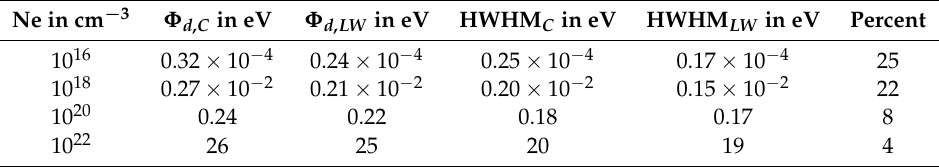
Table 1. Comparison between collision operators for Coulomb interaction Φ d , C and for Lienard Wiechert interaction Φ d , LW (multiplied by ¯ h in eV*s and by a 2 in cm 2 where a 0 is Bohr radius) at a 0 temperature T = 8 × 10 8 K and different densities and for Helium-like Ytterbium Z em = 68, for the radiative transition 1s3d to 1s2p for triplet case. After this muliplication, the following results are in eV. Ne in cm − 3 Φ d , C in eV Φ d , LW in eV HWHM C in eV HWHM LW in eV Percent 10